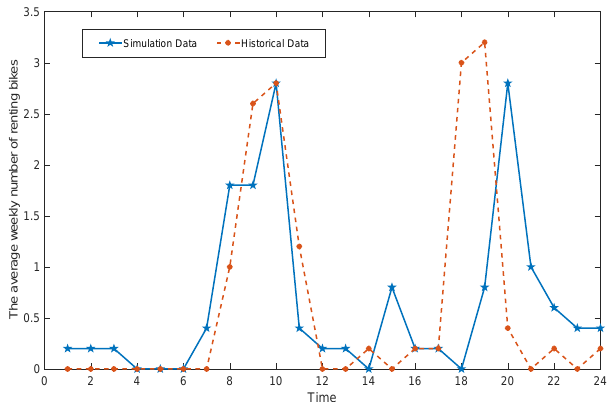
Figure 6. Simulation Results of station named “San Jose Diridon Caltrain Station”.